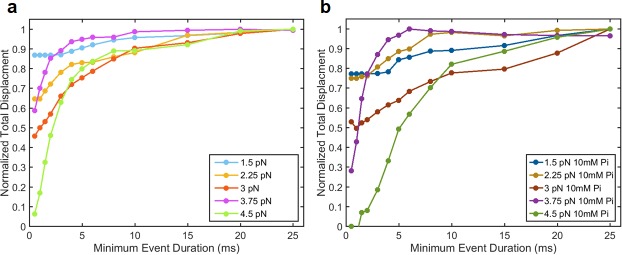
Quantification of ensemble average displacements from force-binned groups plotted against the minimum event duration (MED) included in each group for (a) 0 Pi and (b) 10 mM added Pi.For example, the averages MED = 10 ms represent the average displacement of all events > 10 ms. The plotted displacement is normalized to the largest displacement observed at each force. As more events are excluded (increasing x-axis), the total observed displacement rises, until it nearly plateaus at MED ≥ 15 ms for 0 Pi. This result justifies analyzing events longer than 15 ms separately from short events (e.g. Figure 3) for this data. For 10 mM Pi, the total displacement continued to increase until events shorter than 25 ms were excluded, and thus 25 ms was used as a threshold for the 10 mM Pi data, and the 0 Pi data that were directly compared to it (Figures 4 and 5).